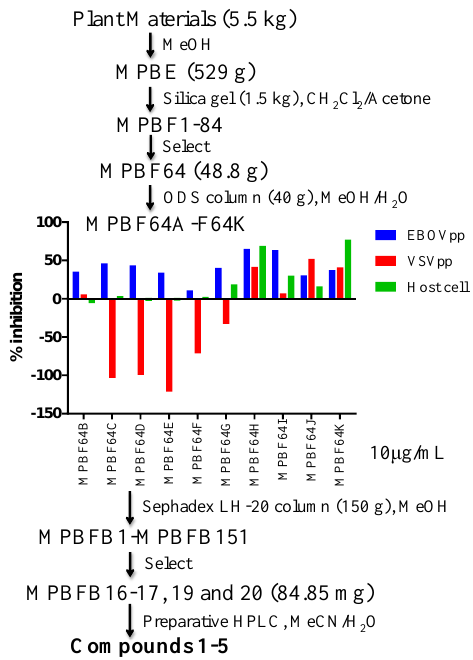
Figure 2. Bioassay-directed fractionation of M. perlarius extract. The stems of M. perlarius (5.5 kg) were extracted by methanol (3 × 32 L, 24 h) at room temperature. The dried methanol extract (MPBE, 529 g) was fractionated by silica-gel normal-phase column chromatography with the use of a gradient elution system of dichloromethane (CH 2 Cl 2 )/acetone, followed by the gradient CH 2 Cl 2 /MeOH, to afford 84 fractions (MPBF1 – 84). MPBF64 (48.8 g), one of the fractions eluted by CH 2 Cl 2 :MeOH 1:1, was found to exhibit an inhibitory effect against EBOVpp, with an IC 50 value of 0.42 µg/mL. A